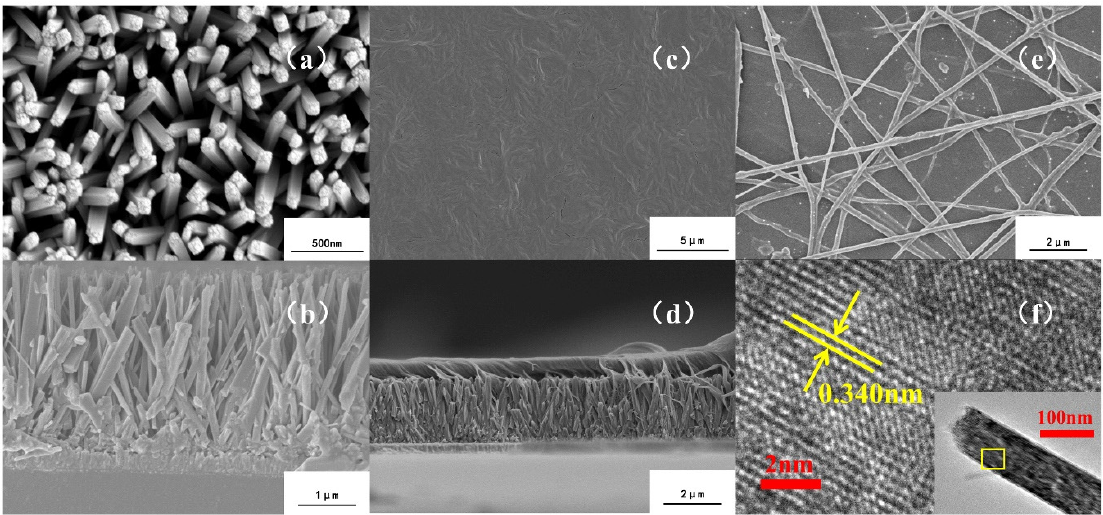
Figure 3. Surface and section-cross SEM images of ( a , b ) TNA; ( c , d ) PVT/TNA; ( e ) PVTNF-PVT/TNA and ( f ) the TEM image of a single TiO 2 nanowire.